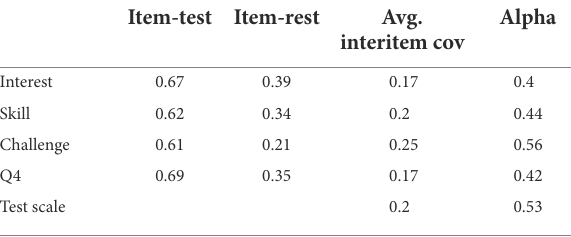
TABLE 2 Reliability using Cronbach’s